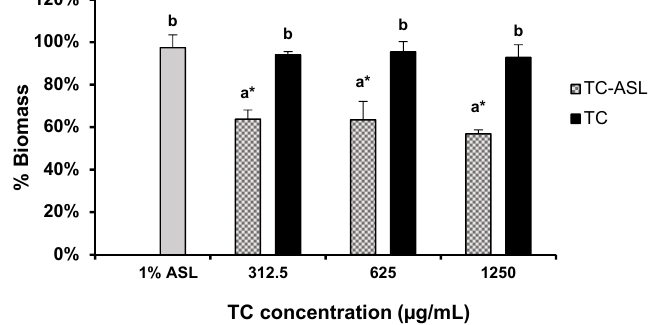
Figure 4. Biomass of E. faecalis biofilm after treatment with TC–ASL, TC, and ASL. The biomass of treated biofilm was expressed relative to control (100%). The results represent the mean ± SD of three replicates in independent experiments. Different letters denote a statistically significant dif- ference ( p ≤ 0.05) between different treatment groups while the same letters show no statistical dif- ference ( p > 0.05) between different treatment groups, including the within-group comparison and between-group comparison. * Denotes a significant difference compared to the control ( p ≤ 0.05). The biofilm structure after different treatments was visualized by CLSM. The control group showed a thick and densely packed biofilm with apparently closely aggregated live cell clusters (green fluorescence) (Figure 6), indicating an intact bacterial cell membrane and undisturbed biofilms. Similar densely packed microcolonies were observed in bio- films treated with TC. A dose-dependent increase in the dead cell population was noted in TC–ASL-treated biofilms as indicated by the fact that more red-stained bacteria were viewed at higher concentrations (Figure 6). Figure 5. Quantification of ( a ) biofilm thickness or ( b ) biofilm volume after treatment with TC–ASL, TC, and 1% ASL. The biofilm thickness was obtained from the z-stacks while the volume of treated biofilm was expressed relative to the control (sterile-water-treated biofilm)(100%). The results rep- resent the average of three independent experiments ± SD. Different letters denote a statistically significant difference ( p ≤ 0.05) between different treatment groups while the same letters show no statistical difference ( p > 0.05) between different treatment groups, including the within-group com- parison and between-group comparison. * Denotes a significant difference compared to the control ( p ≤ 0.05).